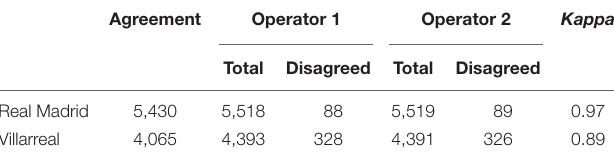
TABLE 3 | Number of events coded by different operators during two data